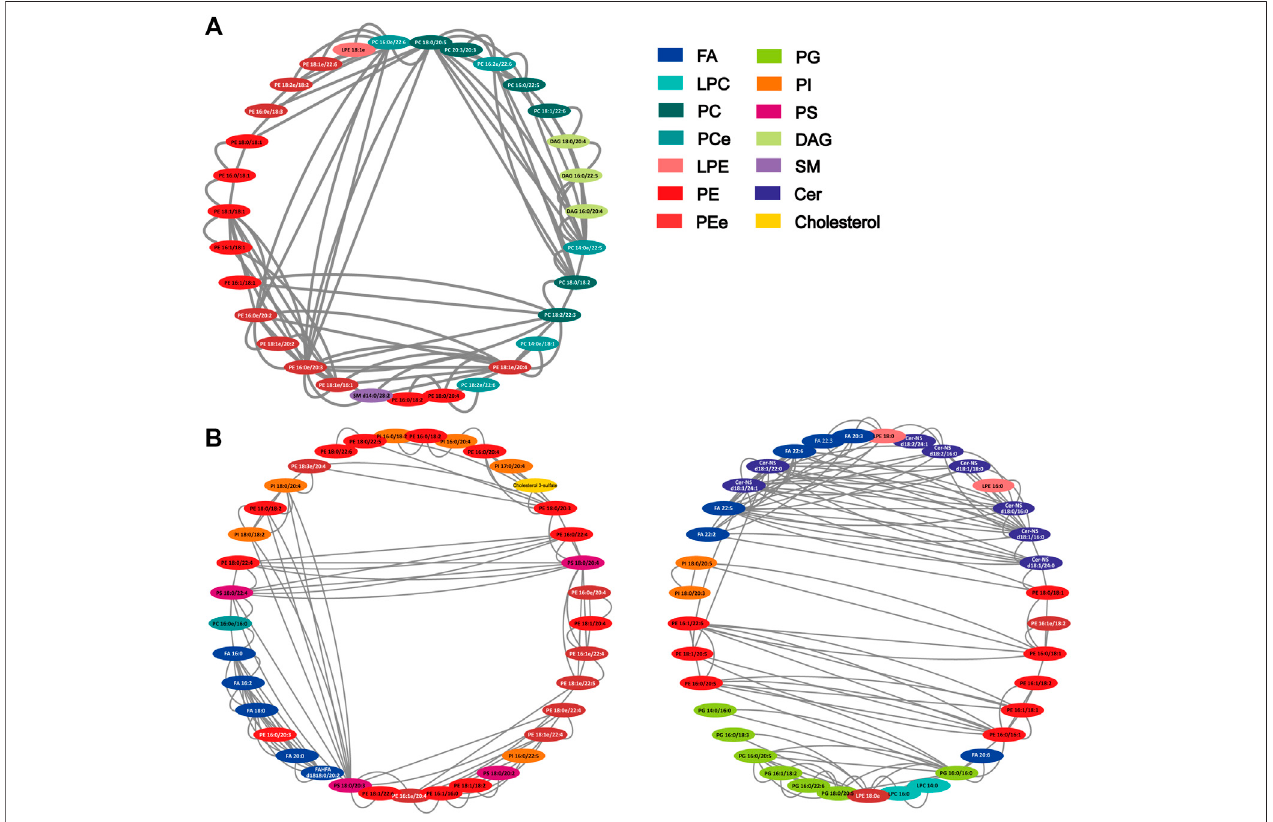
FIGURE 5 | Correlation network of differentially expressed lipids. (A) positive ion mode (47 nodes, 118 edges); (B) negative ion mode (96 nodes, 273 edges). The network was generated by Cytoscape 3.8.2 with attribute circle layout. Nodes were screened by FDR value < 0.001 and Spearman correlation coef fi cient r 2 > 0.75. Edges represent the value of r 2 between two